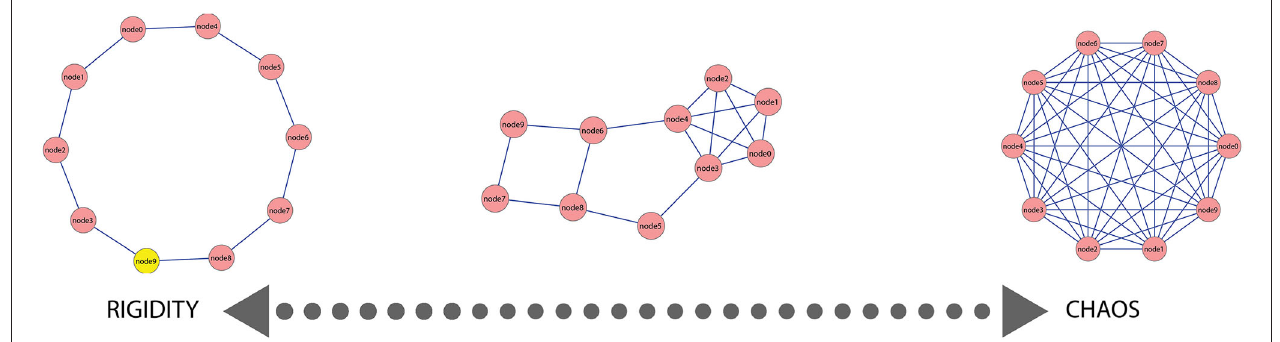
right) where each node is connected to all other nodes. In between lies a more integrated state (center) where part of the nodes are connected to few other nodes (rigidity) and a few nodes are connected to many other